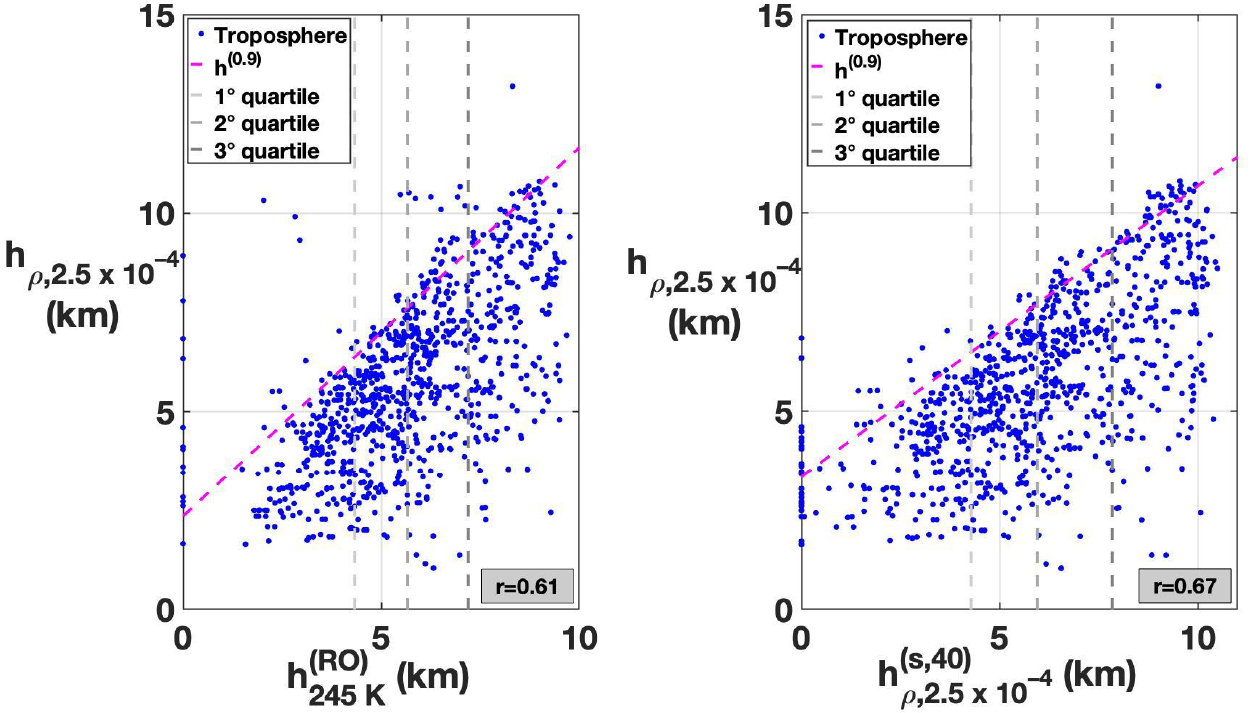
( RO ) ( s ,30 ) ( left ) and h ( right ). 245 K (cid:36) ,10 − 4 (𝑠,30) 𝐾(𝑅𝑂) ( left ) and ℎ 245 𝜚,10 −4 (𝑏) altitudes, concerning real temperatures. Data below 𝑖